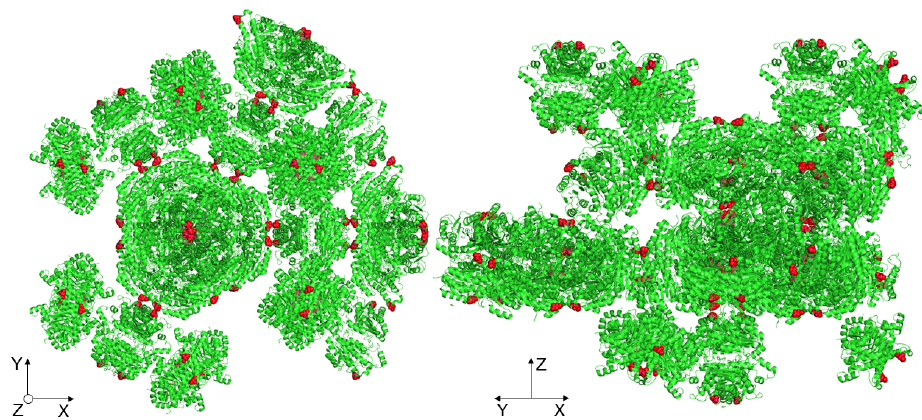
Figure 7. Highlighting the manipulated amino acids (cysteine) at one of the crystal contacts along the c ‐ axis (Z ‐ direction).